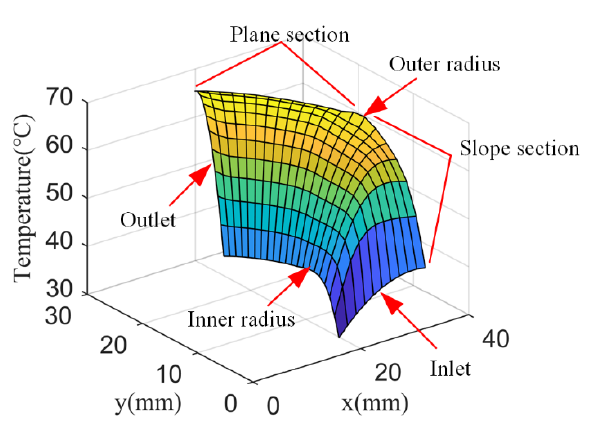
Figure 11. Top foil temperature distribution.